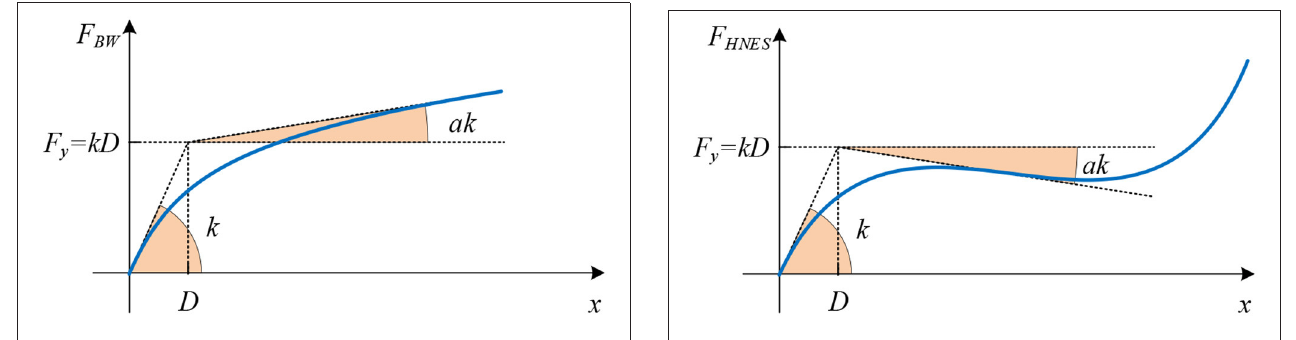
FIGURE 4 | Response of Bouc Wen model under displacement-controlled monotonic loading.